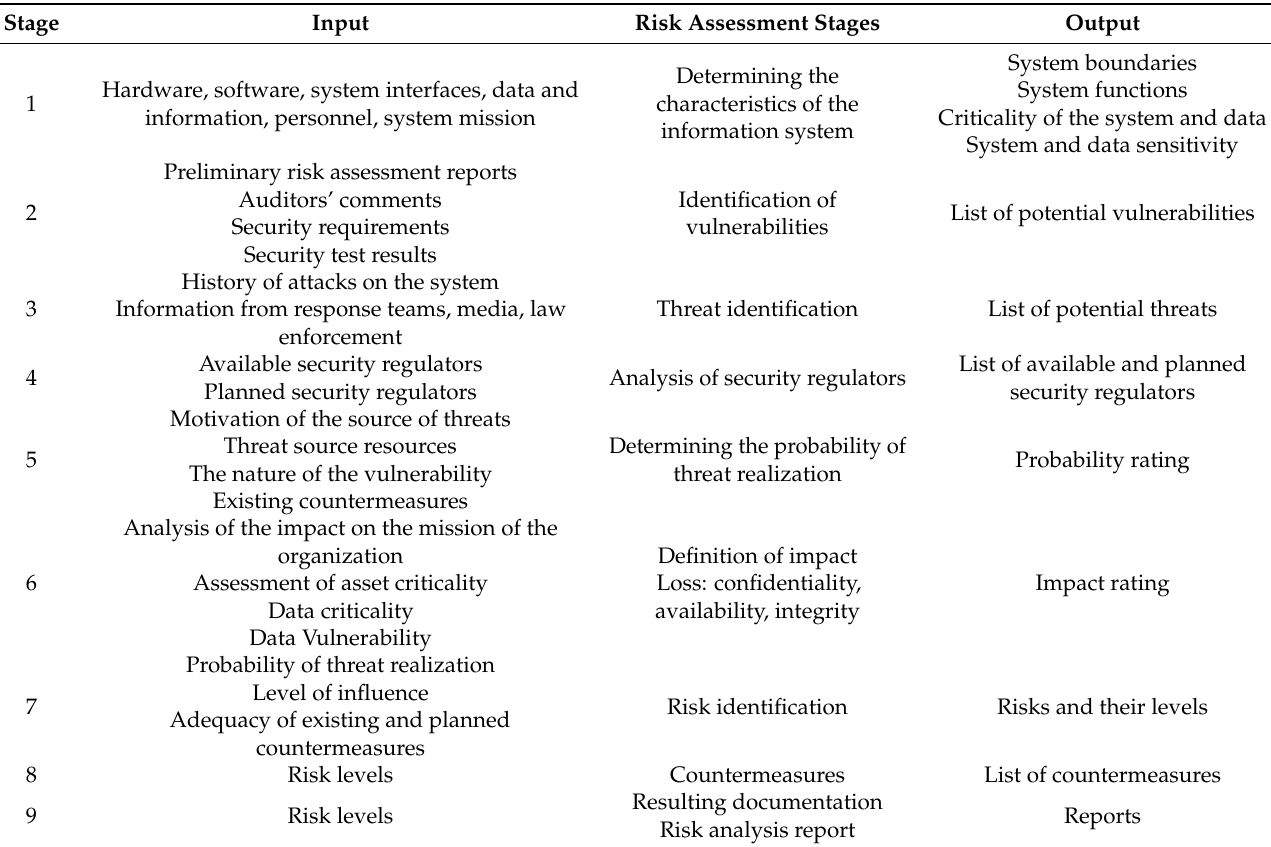
Table 1. Stages of risk